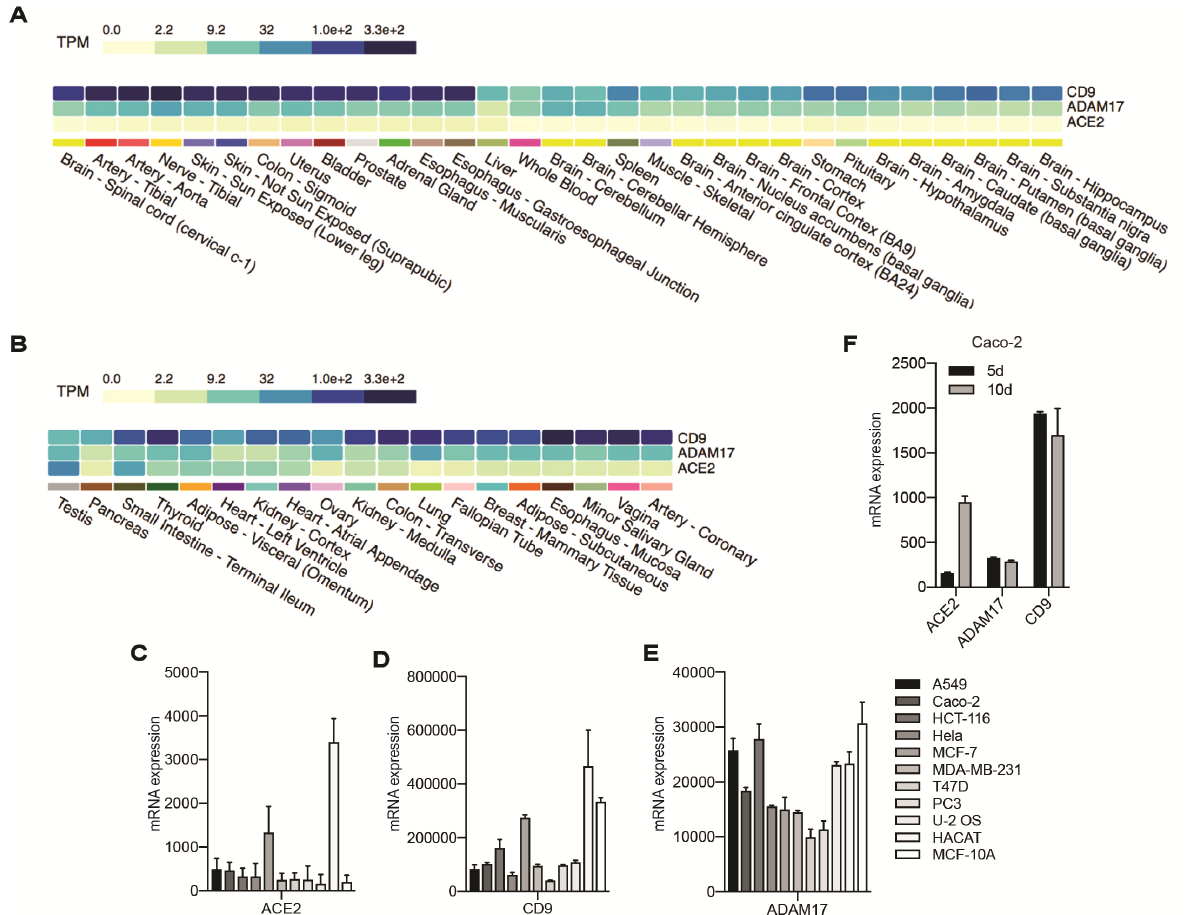
Figure 1. Analysis of mRNA expression levels for ACE2, ADAM17 and CD9 in tissues and cells. ( A , B ) Analysis of datasets from GTexPortal (https://www.gtexportal.org/home/multiGeneQueryPage/ ACE2,ADAM17,CD9, accessed on 28 January 2022). ( A ) shows tissues with relatively lower ex- pression of ACE2 and ( B ) shows tissues with relatively medium or high expression of ACE2. TPM refers to Transcript Per Million. Color code (light green to dark blue) correlates with transcript levels (from light green = lowest to dark blue = highest). ( C – E ) Signal intensities (absolute mRNA expression) of ACE2 ( C ), CD9 ( D ) and ADAM17 ( E ) in the indicated cultured cell lines (data from GSE41445 microarray datasets). ( F ) Signal intensities for mRNA expression of ACE2, CD9 and ADAM17 (GSE7259 microarray datasets) in human intestinal (colon) carcinoma Caco-2 either of low (5-day culture, black bars) or high (10-day culture, grey bars) differentiation. Note that ACE2 mRNA expression is upregulated upon